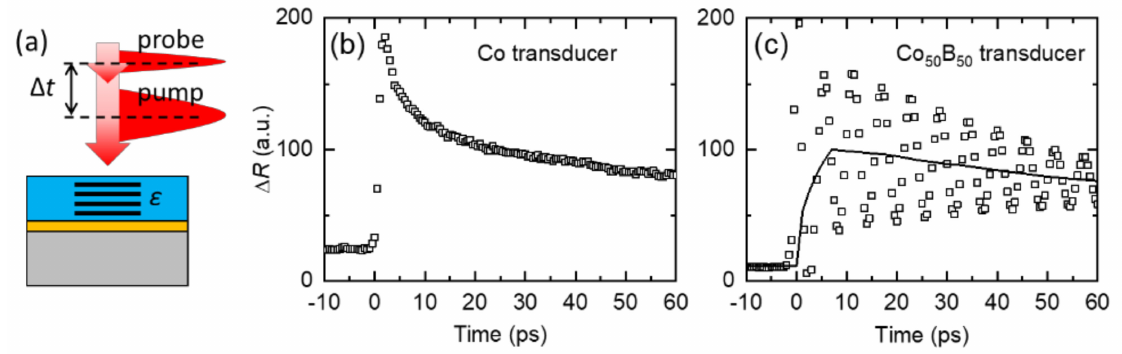
Figure 3. ∆ R comparison of the Co and Co 50 B 50 transducers. ( a ) Schematics for detection of ∆ R , which was caused by changes in the strain ( ε ). The blue/orange/gray layers represent the transducer/interface/substrate, respectively. ∆ R results of the ( b ) sap/Co (10 nm)/Pt (2 nm) and ( c ) sap/Co 50 B 50 (10 nm)/Pt (4 nm) sample. The black squares are experimental data. The black line in ( b ) represents the background temperature